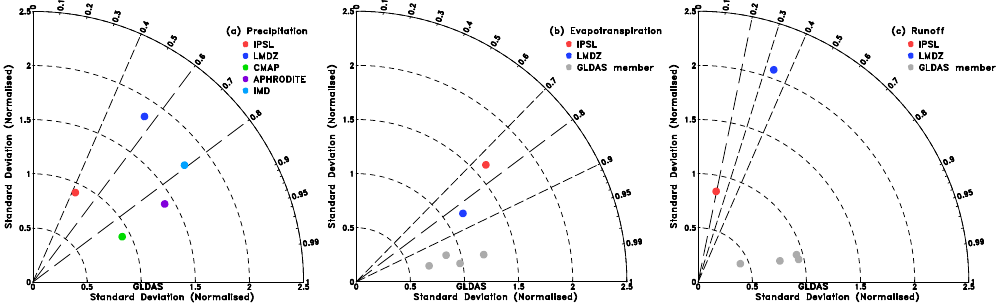
Figure 4. Taylor diagram for the annual-mean (a) precipitation, (b) evapotranspiration and (c) total runoff climatology (1979–2005) from the IPSL and LMDZ model simulations averaged over land grid points in India (70–90 ◦ E; 10–28 ◦ N). The radial coordinate shows the standard deviation of the spatial pattern, normalized by the observed standard deviation. The azimuthal variable shows the correlation of the modelled spatial pattern with the observed spatial pattern. The distance between the reference data set (GLDAS) and individual points corresponds to root mean square error